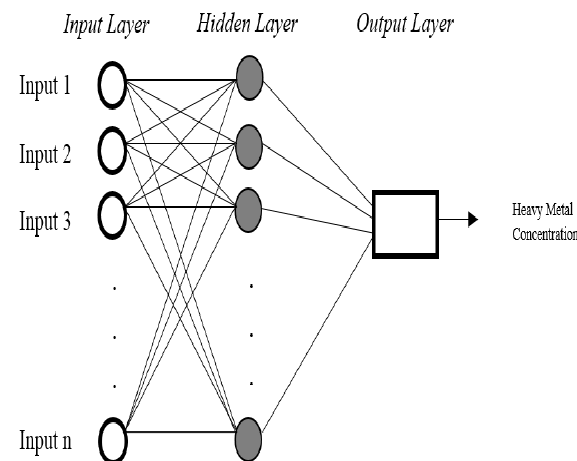
Figure 2. A schematic architecture of the artificial neural network (ANN) model used in this study An ANN model is developed in